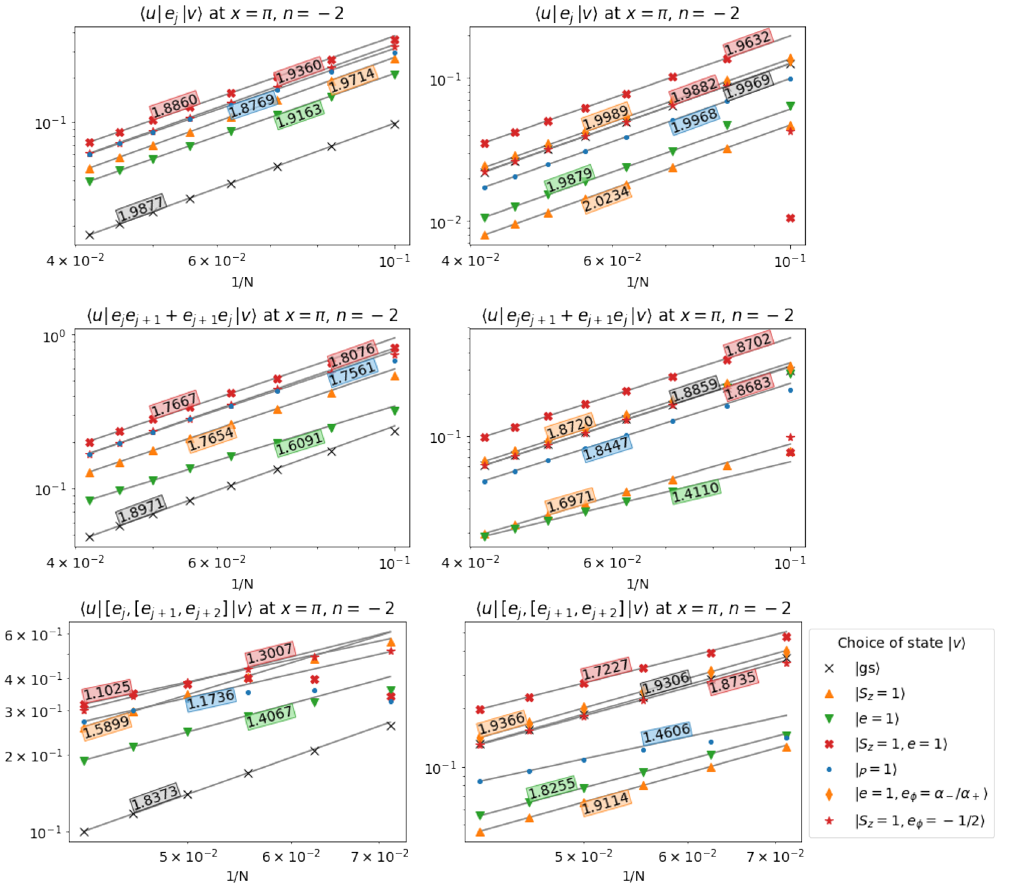
Figure 8 . Absolute value of matrix elements, plotted using the same conventions as in (cid:12)gure 3 up to the choice of j u i : for each state j v i the state j u i corresponds to the same choice of lattice parameters up to a change in momentum sector, p ! p +2. To the left, the lowest energy state for each choice of lattice parameters is used for j u i . To the right, the (cid:12)rst excited energy state is used for j u i instead. In case of choices of j v i showing particularly strong (cid:12)nite size e(cid:11)ects ( j S z = 1 ; e = 1 i and j p = 1 i in the lower left plot, j p = 1 i in the lower right plot) the linear (cid:12)t is performed using only the two leftmost points.